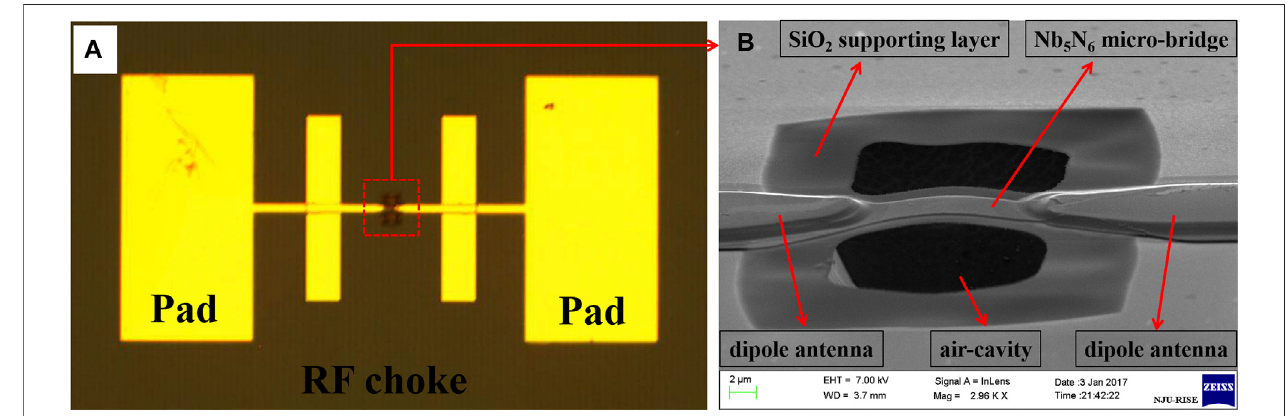
FIGURE 4 | (A) Image of the fabricated antenna-coupled Nb 5 N 6 THz detector. (B) SEM micrograph of the Nb 5 N 6